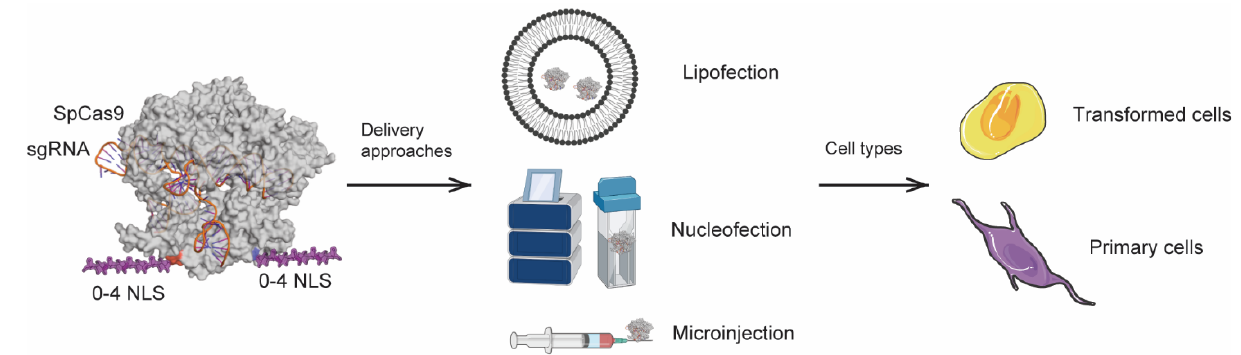
Figure 1. Schematic presentation of the experimental procedures in this